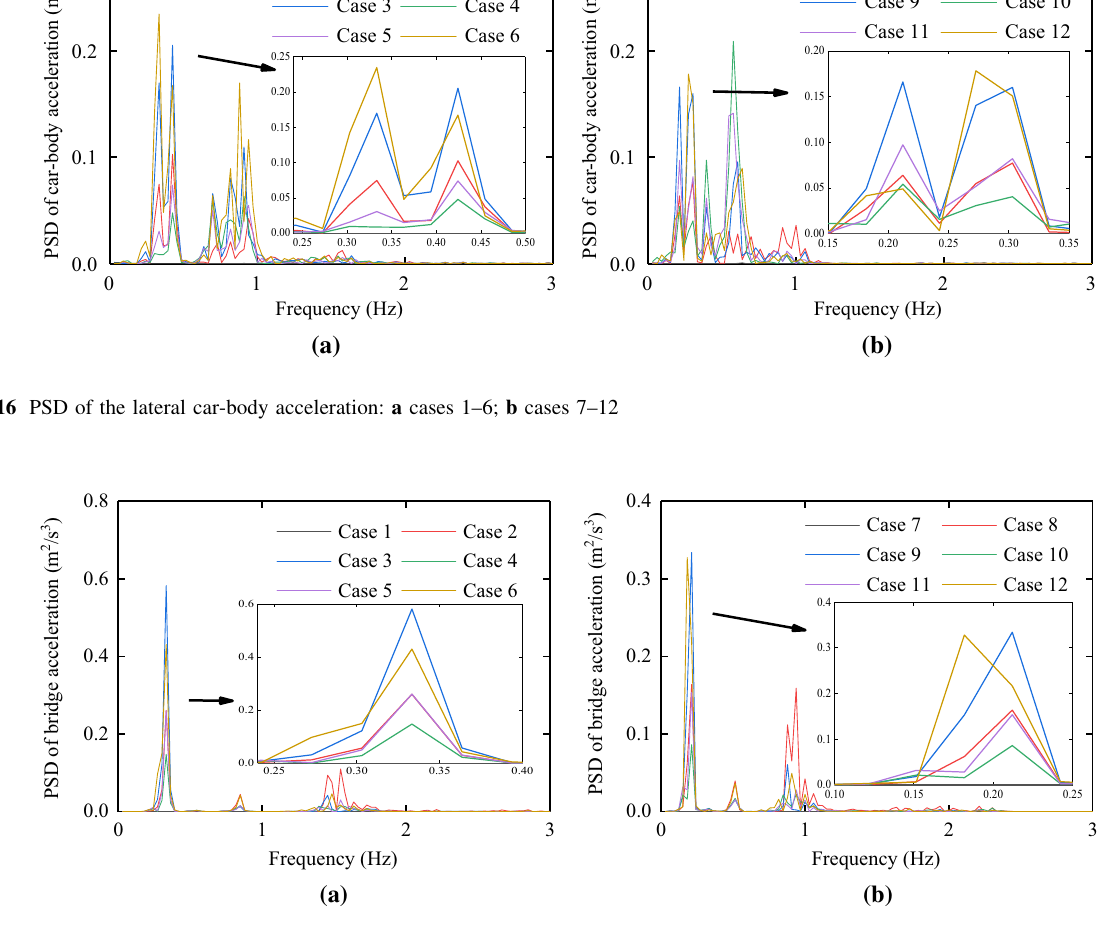
Fig. 12. The same observations can be identified through the running safety indices of the lateral wheel–rail contact force and the derailment factor, as shown in Table 4. In